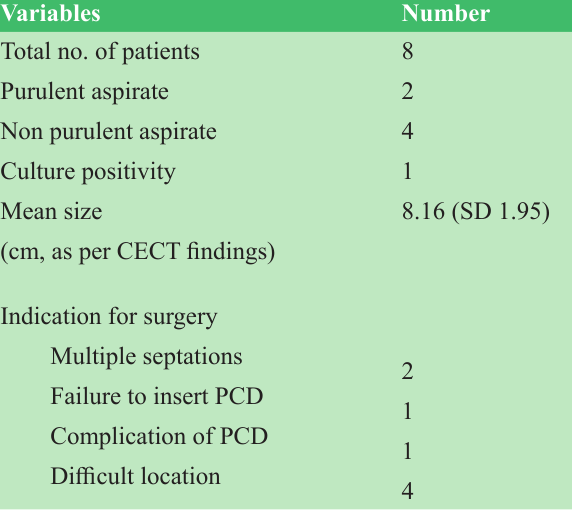
Table 1: Variables Number Total no. of